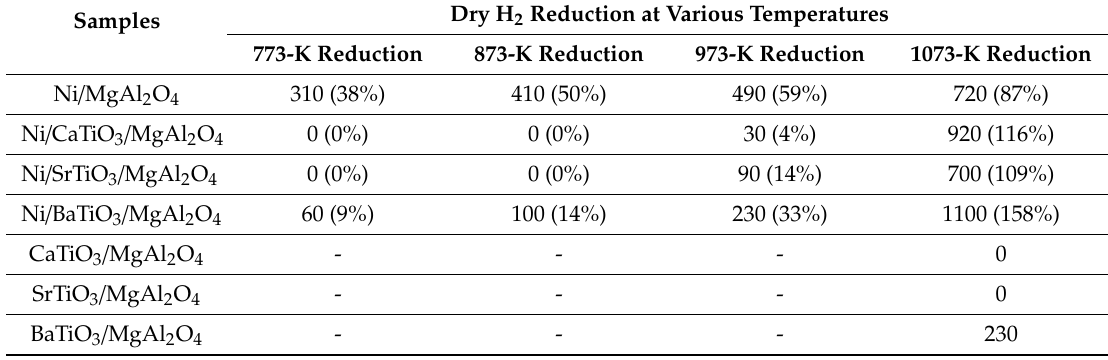
Table 2. Oxygen uptakes from flow titration for various samples after di ff erent reduction pretreatments.